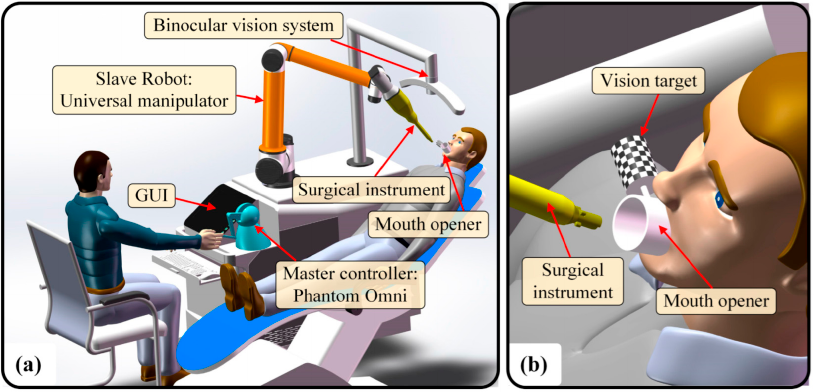
Figure 1. The OSRS: ( a ) The overall system; ( b ) Local magnification of the mouth opener.